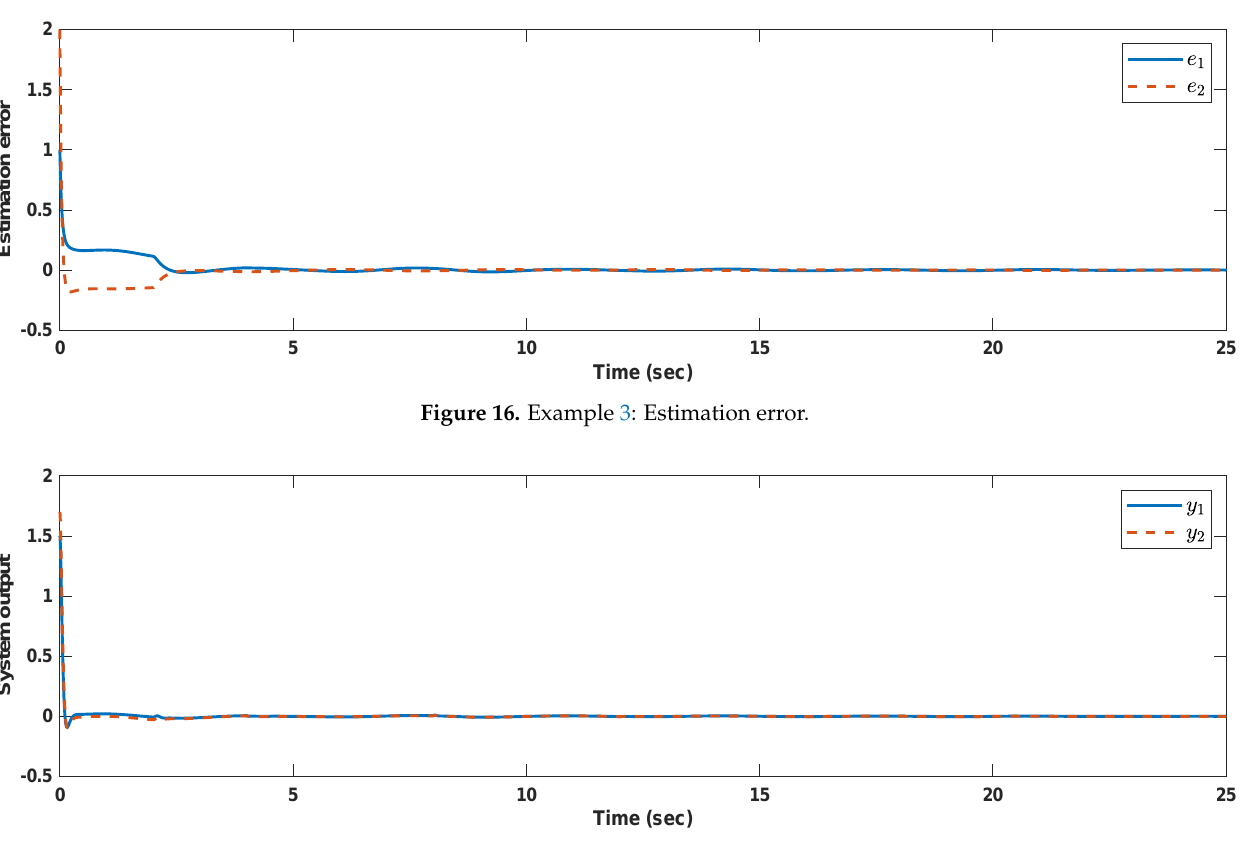
Figure 17. Example 3: Time response of the F − 18 aircraft system’s